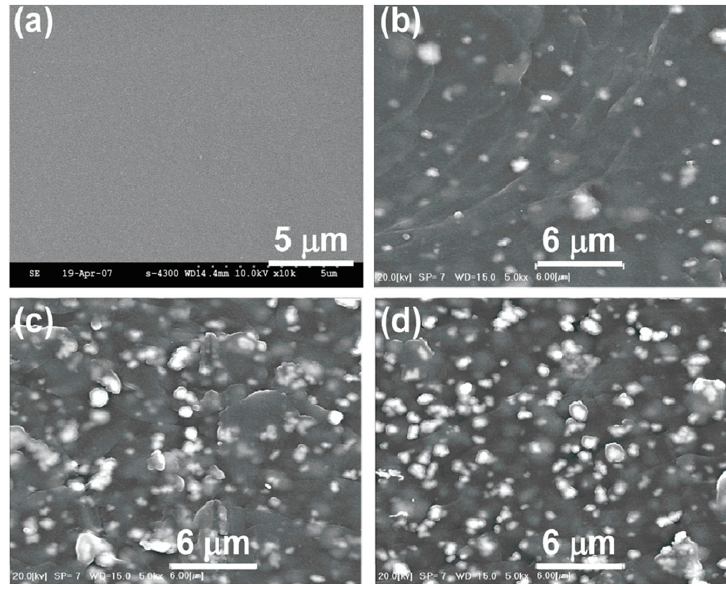
Figure 7. Surface SEM images of cellulose ( a ) and SnO 2 -cellulose hybrid thin films as a function of SnO 2 concentration: 10 wt % ( b ) 20 wt % ( c ) and 30 wt % ( d ) [70]. SnO 2 concentration: 10 wt % ( b ) 20 wt % ( c ) and 30 wt % ( d )